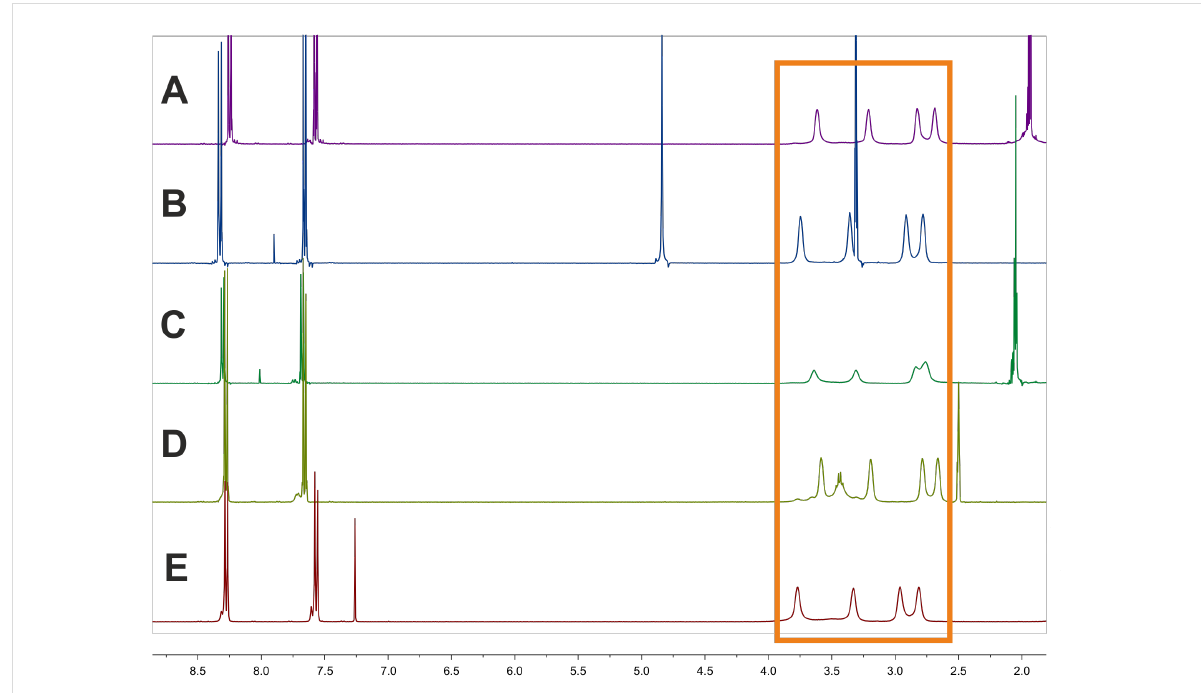
Figure 1: 1 H NMR spectra of compound 3a measured in five different solvents: (A) acetonitrile- d 3 , (B) methanol- d 4 , (C) acetone- d 6 , (D) DMSO- d 6 and (E) CDCl 3 (orange: region of